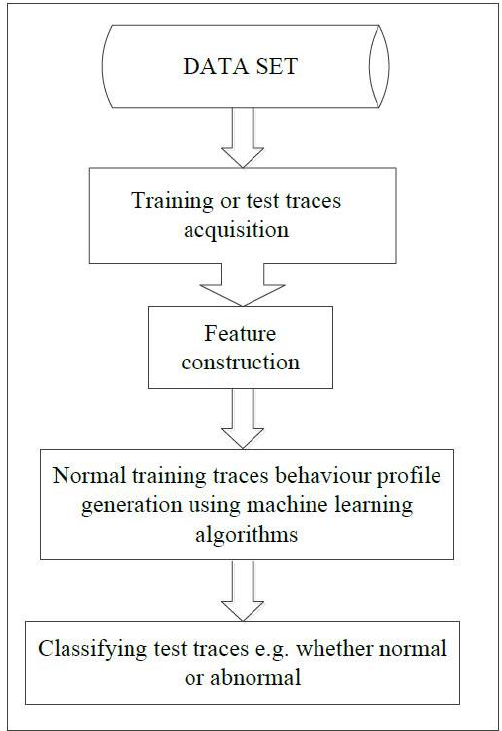
Figure 2. Anomaly detection frame work for the data sets complexity analysis.